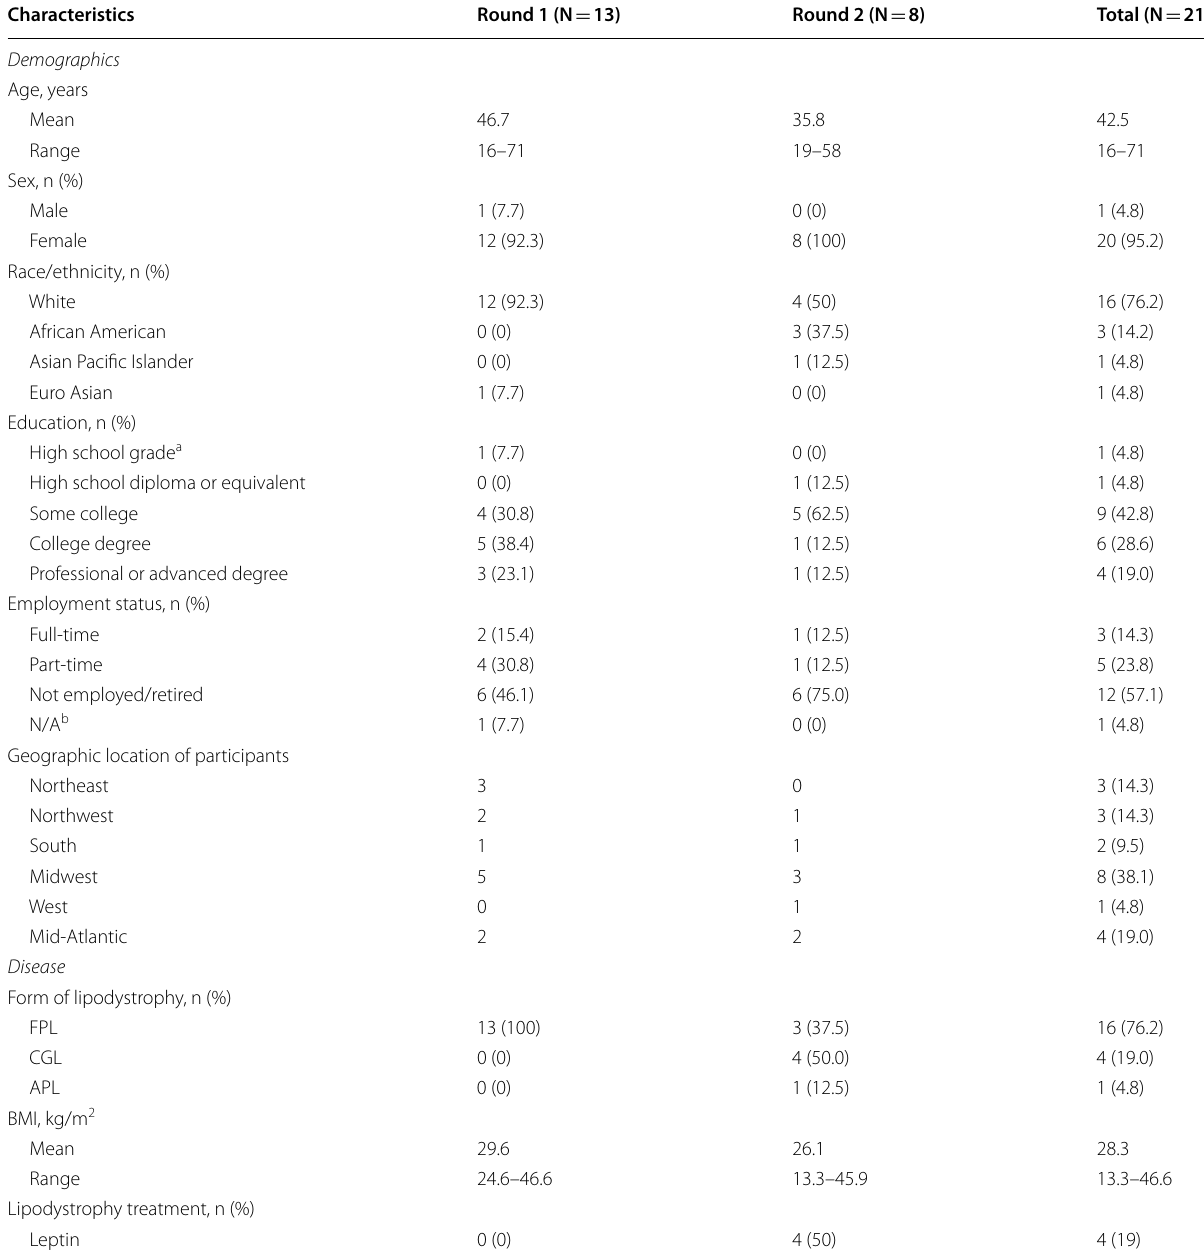
Table 1 Demographic and clinical